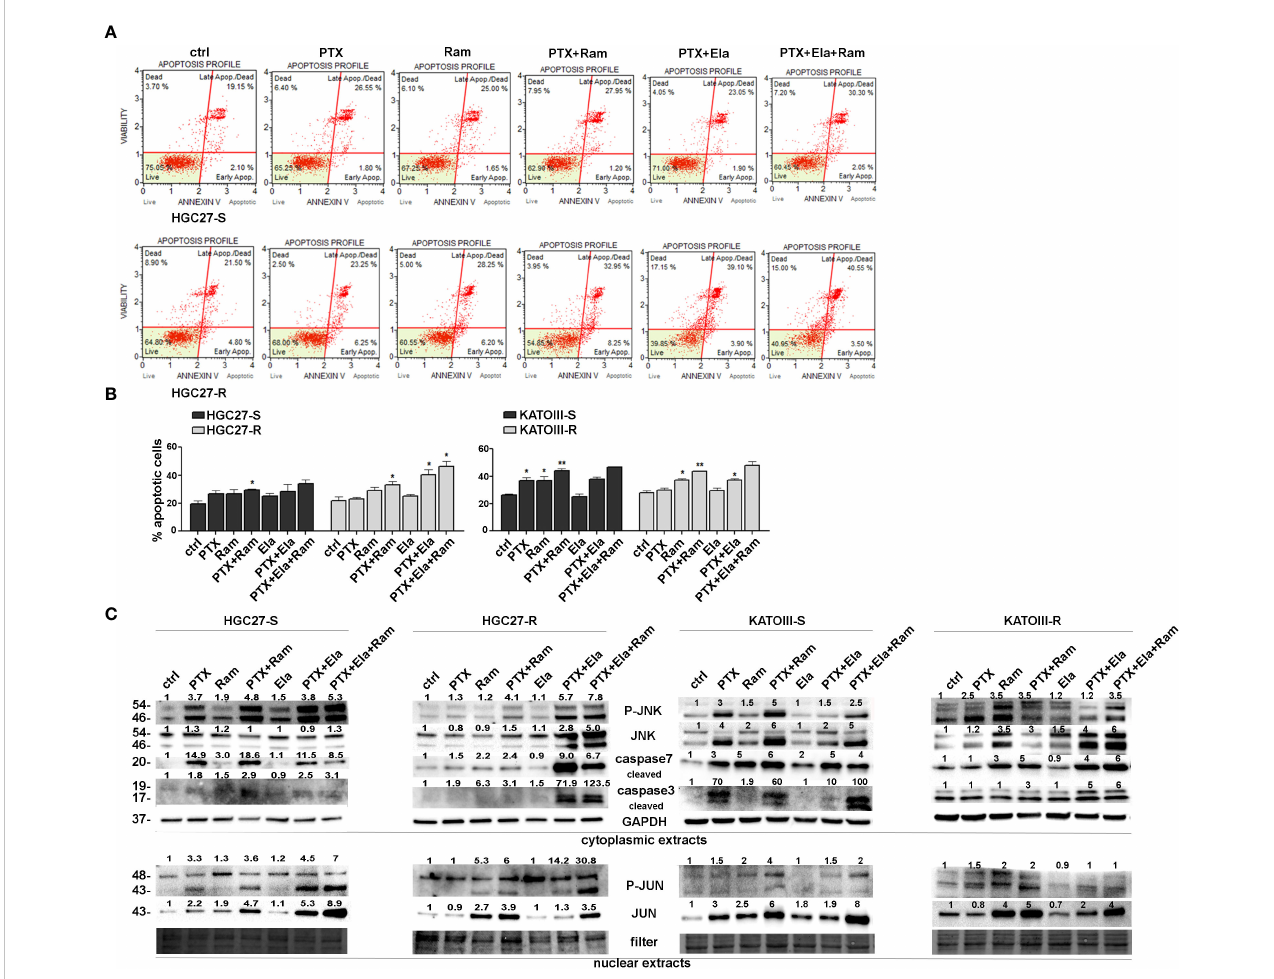
FIGURE 4 Apoptotic effects of PTX, Ram and Ela in GC cell lines. (A) Muse Annexin V Cell Assay for HGC2 S/R and KATOIII S/R cell lines assessed after 48 hrs of 2 nM (for KATOIII) or 4 nM (for HGC27) PTX, 100 m g/mL Ram and 100 nM Ela alone or in combination treatments. In the panel, the results obtained for HGC27-S/R were shown; (B) Apoptosis results HGC27 S/R and KATOIII S/R deriving from three independent experiments were expressed as means ± SD and reported in the relative graphs. Statistical analysis was assessed comparing the values obtained using single drug treatment to those of corresponding untreated cells and the combined treatments to those of the single treatments, *p<0.05; **p<0.01; (C) Representative Western Blotting analysis performed in HGC27 S/R and KATOIII cells relative to the nuclear expression of P-JUN/JUN and the cytoplasmic expression of P-JNK/JNK and cleaved Caspase 3/7. Nuclear protein extracts have been normalized using stain free technology. GAPDH has been used as a normalizer of cytoplasmic protein extracts. Values indicating normalized expression levels were shown on each